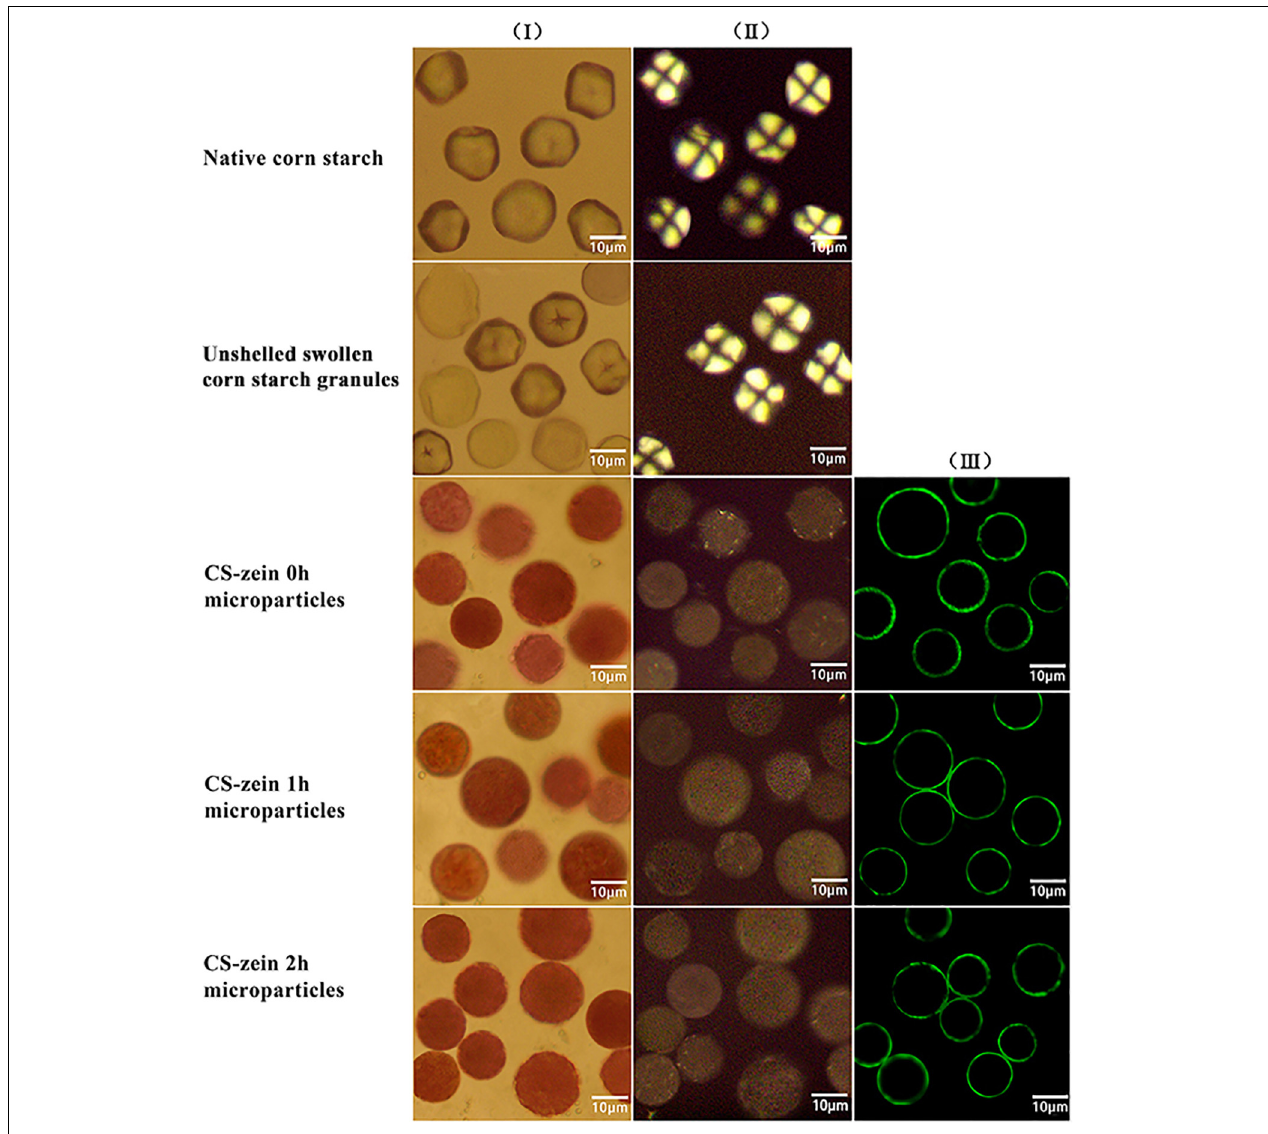
FIGURE 2 | Native corn starch (line I), unshelled swollen corn starch granules (line II) and core-shell starch/zein microparticles crosslinked by TGase for 0 h (line III), 1 h (line IV), and 2 h (line V). Optical microscopy images (columns I and II); confocal scanning laser microscopic images (column III). It should be noted that not all of the images in each line were taken on the identical